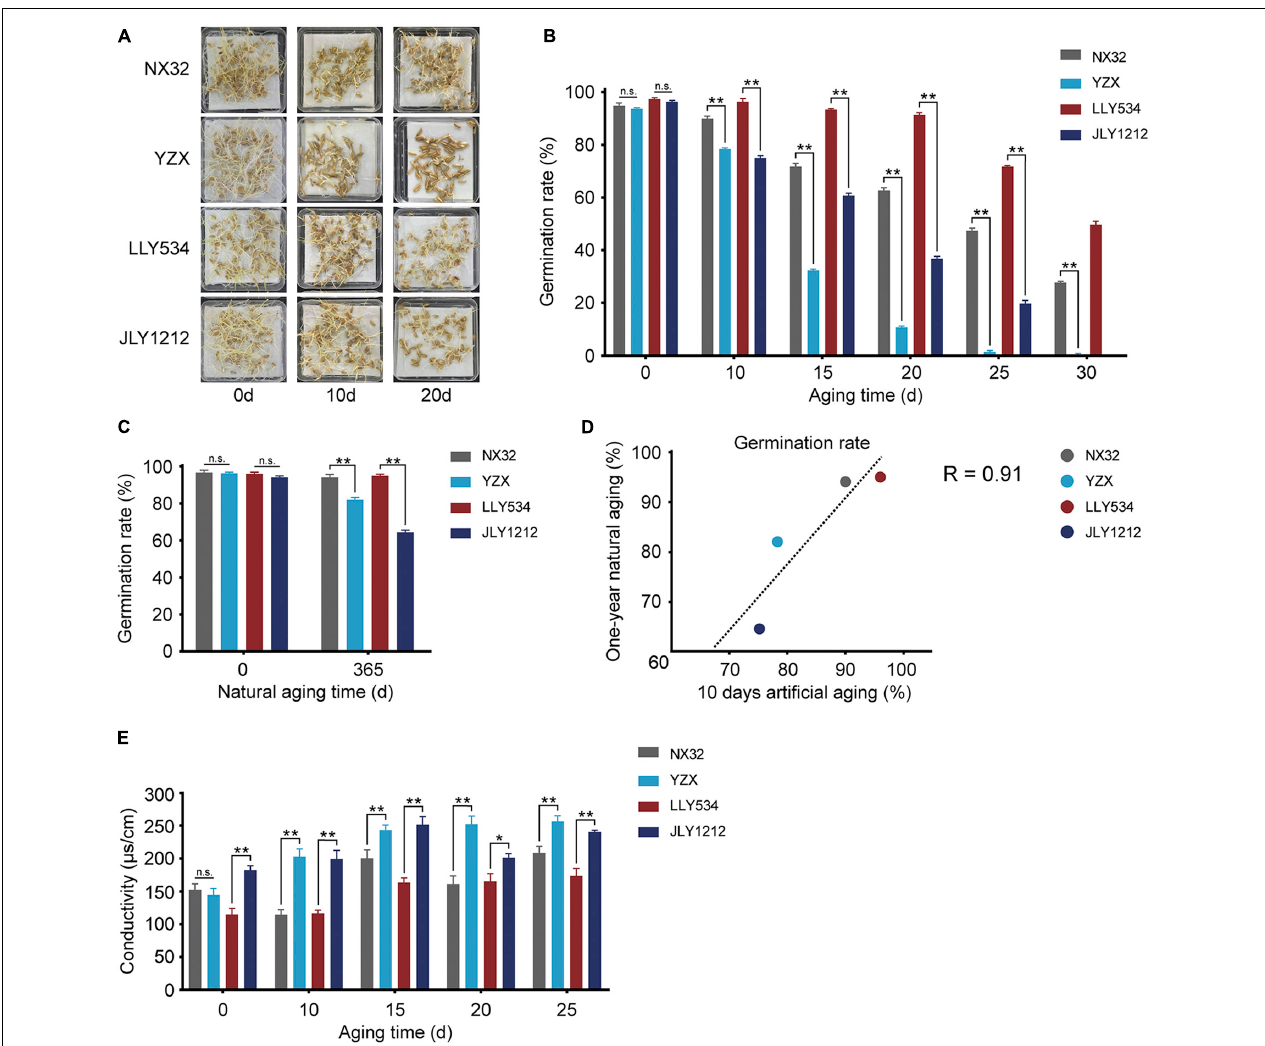
FIGURE 2 | Germination rate and conductivity of seeds of the four rice varieties. (A,B) Germination rates of two conventional rice varieties (HL rice variety NX32 and LL rice variety YZX) and two hybrid rice varieties (HL rice variety LLY534 and LL rice JLY1212) under artificial aging conditions (0, 10, 15, 20, 25, and 30 days) (n.s., not significant; * P < 0.05, ** P < 0.01, one-way ANOVA with Tukey’s test). (C) Germination rates of two conventional varieties (HL rice variety NX32 and LL rice variety YZX) and two hybrid varieties (HL rice variety LLY534 and LL rice variety JLY1212) under natural aging for 1 year (* P < 0.05, ** P < 0.01). (D) Correlation analysis between natural aging (1 year) and artificial aging (10 d) of two conventional varieties (HL rice variety NX32 and LL rice variety YZX) and two hybrid varieties (HL rice variety LLY534 and LL rice variety JLY1212) (Pearson’s R = 0.91). (E) Seed conductivity of two conventional varieties (HL rice variety NX32 and LL rice variety YZX) and two hybrid varieties (HL rice variety LLY534 and LL rice variety JLY1212) under artificial aging conditions (0, 10, 15, 20, 25, and 30 d) (n.s., not significant; * P < 0.05, ** P < 0.01, one-way ANOVA with Tukey’s